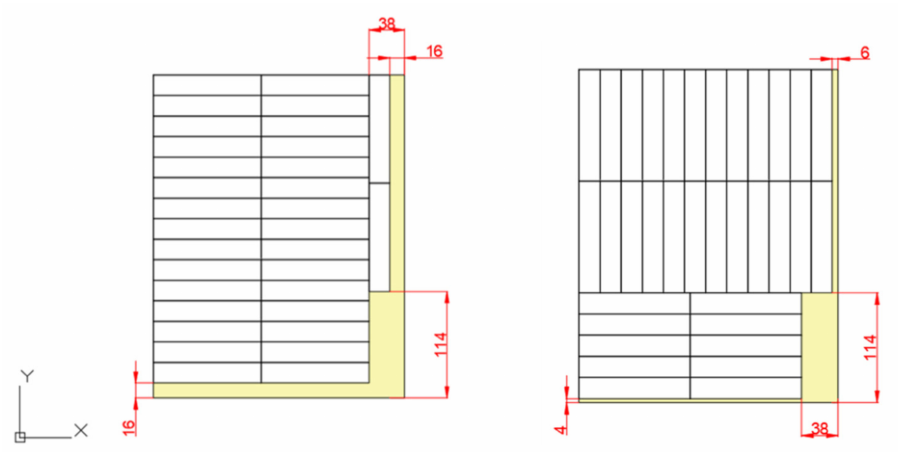
Figure 6. Toshiba SCiB cell disposition in one module, developed for configuration 2 ( left side) and 3 ( right side).